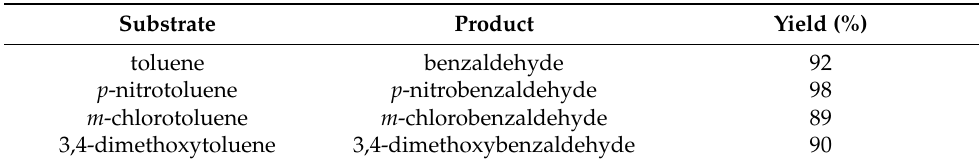
Table 1. Representative examples of the oxidation of benzyl alcohols to the corresponding benzalde- hydes via laccase/ABTS catalysis.